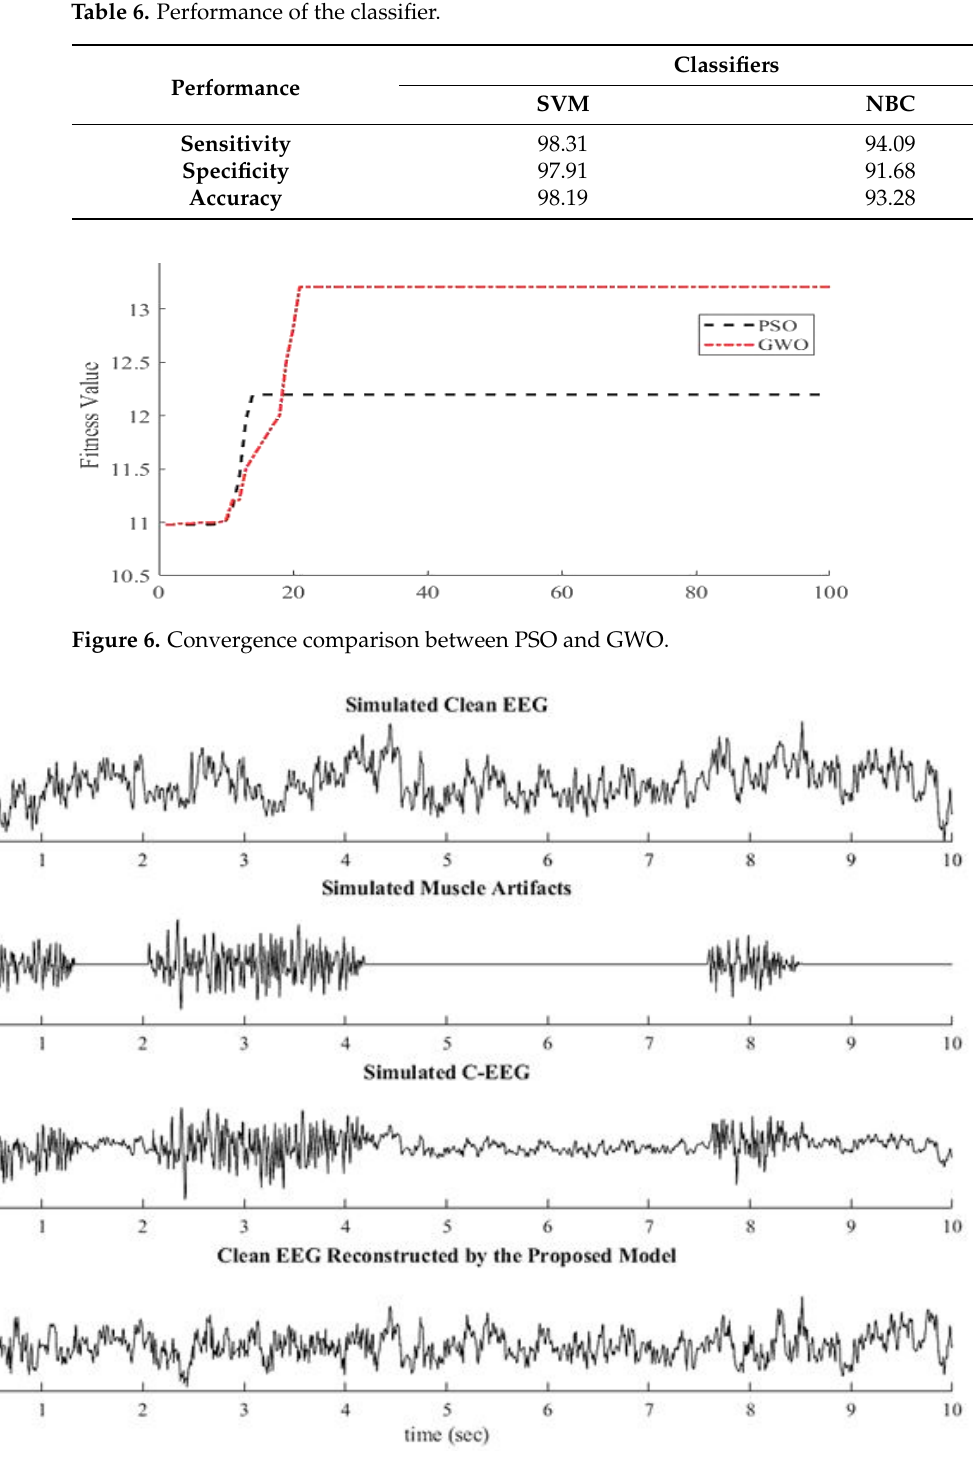
Figure 7. Simulated EEG signal and its corrected EEG signal: ( a ) Simulated Clean EEG Signal, ( b ) Simulated EMG Artifact Signal, ( c ) Simulated Corrupted EEG Signal, and ( d ) Clean EEG Recon- structed by the proposed model.